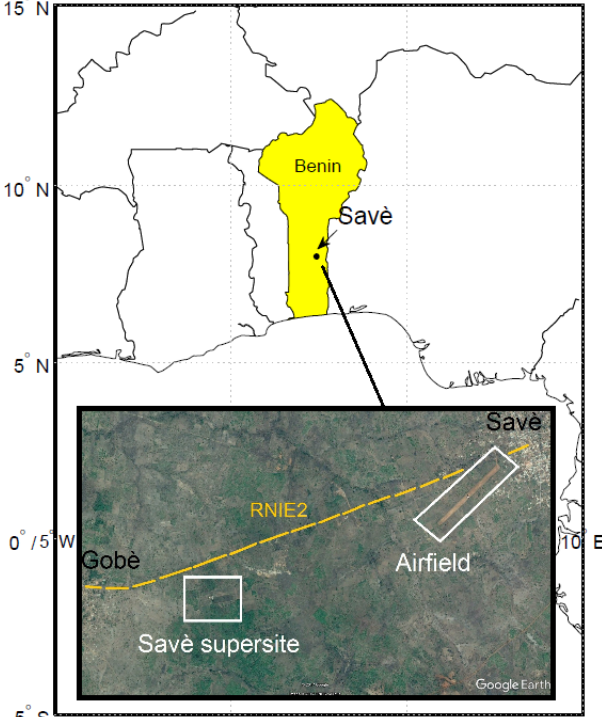
Figure 4. The map shows the position of the measurement site Savè in Benin (marked in yellow), West Africa. The UAS ALADINA was operated at the local airfield of Savè during the field exper- iment DACCIWA from 2 until 16 July 2016. The Savè supersite of the Karlsruhe Institute of Technology (KIT) and Université de Toulouse III–Paul Sabatier (UPS) was located in the south-west with a distance of 4km to the airfield. The sites are connected via the main road RNIE2 (dashed yellow line). The picture was created with Google Earth© on 28 April